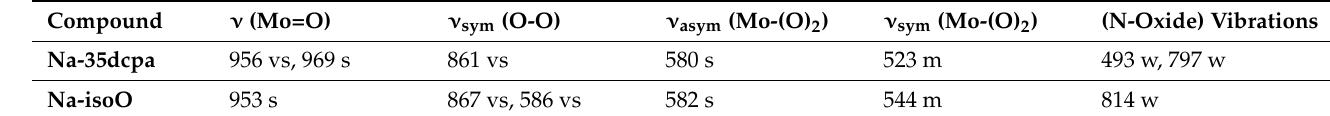
Table 2. IR spectra vibrations and band assignments connected with oxodiperoxido- molybdate